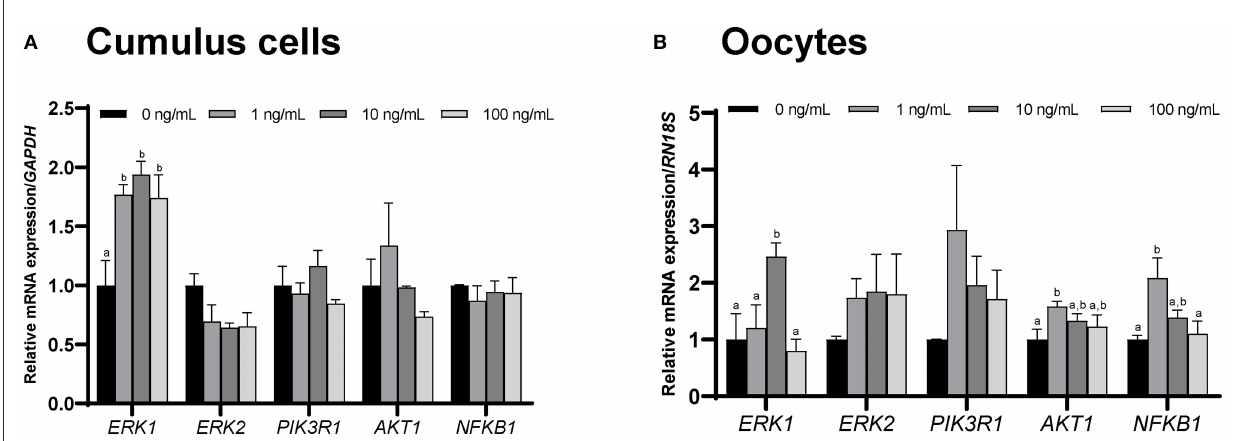
FIGURE5 mRNA levels of CCL2 signaling pathway-related genes. Levels of ERK1, ERK2, PIK3R1, AKT1 , and NFKB1 were assessed in groups of CCs (A) and oocytes (B) supplemented with 0, 1, 10, and 100ng/mL of CCL2 during IVM. Data is represented as mean ± SEM. The experiment was replicated three times. Bars with different letters (a, b) are significantly different ( p < 0.05).